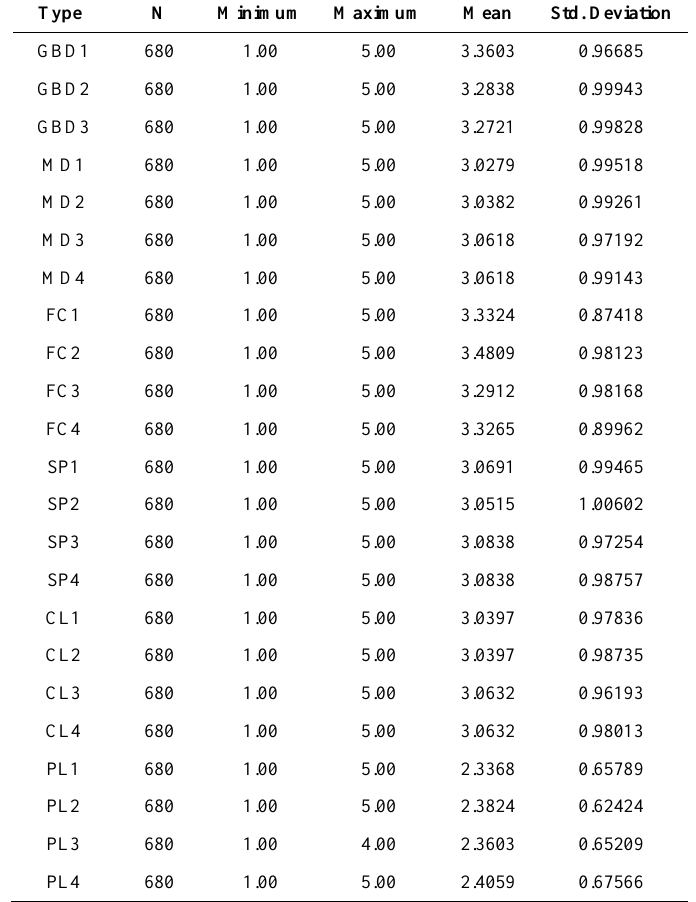
Table 1. Descriptive statistics for factors affecting the green bank